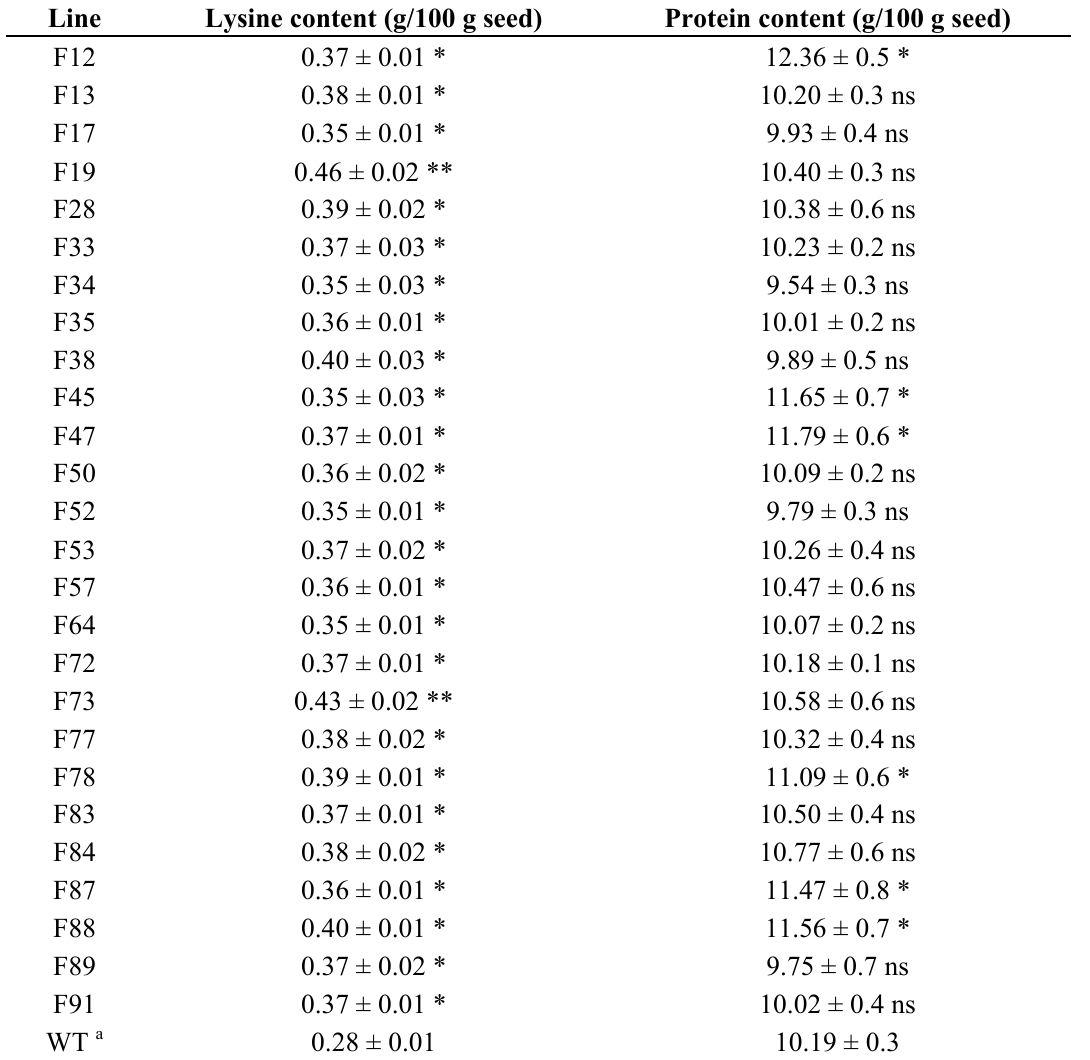
kernels in 26 transgenic 1